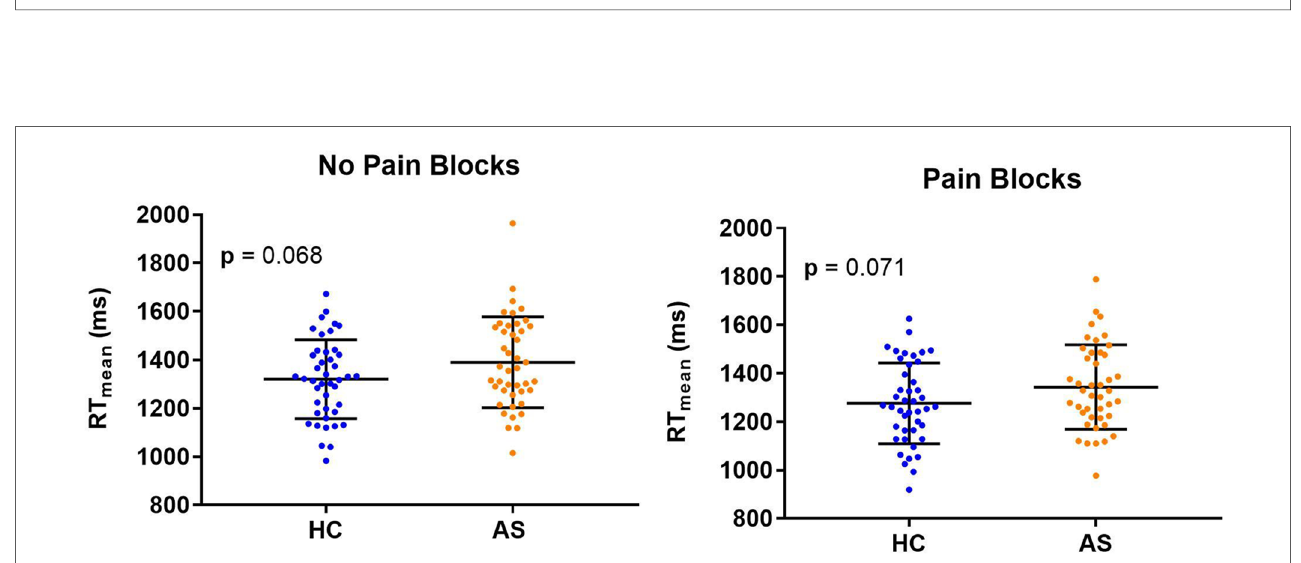
FIGURE 1 Change in individual mean task reaction times (RT) from the no-pain to the pain blocks for each individual in the healthy controls (HCs) and ankylosing spondylitis (AS) groups. A-types are represented by the green lines. P -types are represented by the red lines.